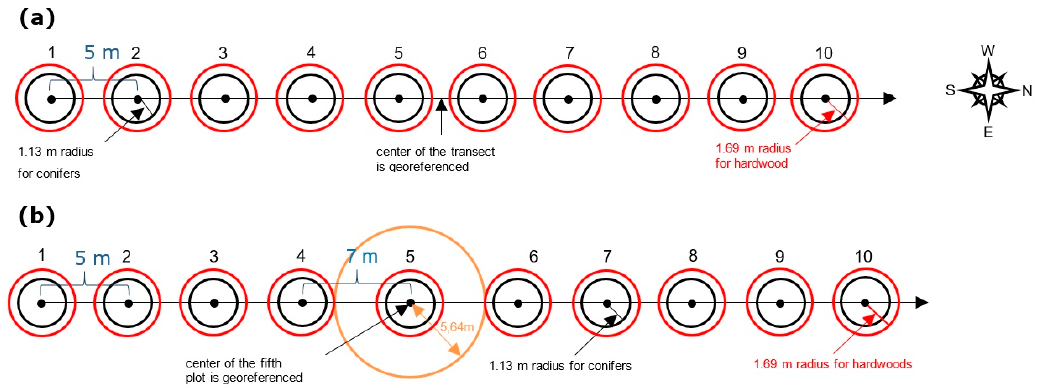
Figure 2. ( a ) Configuration of the micro-plots in a transect used in the 2007–2011 monitoring of post-harvest regenerating stands. ( b ) Configuration of the plot and the microplots in a transect for the 2015 stratified inventory.